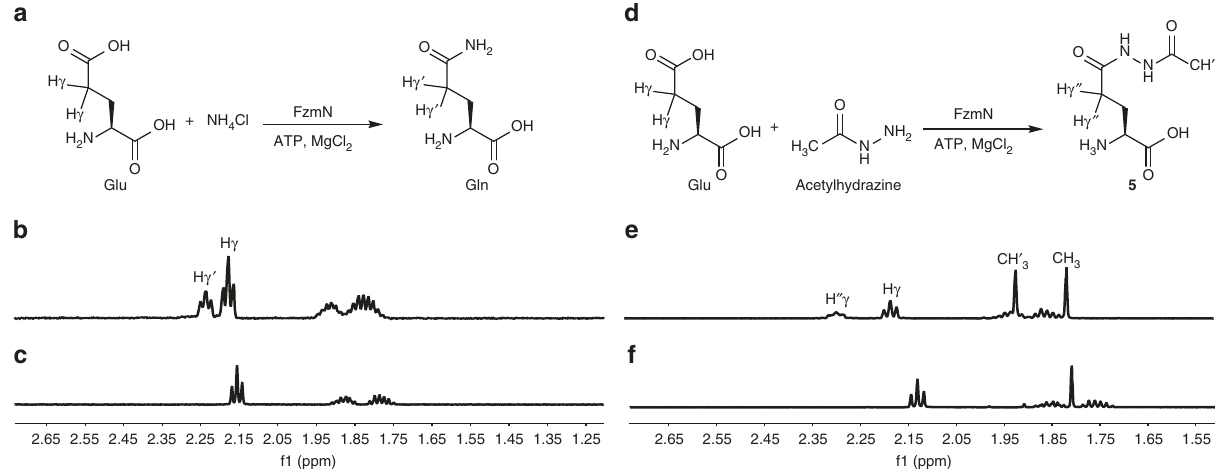
Fig. 4 1 H NMR analysis of FzmN activity. a The canonical glutamine synthetase reaction catalyzed by FzmN. The γ -protons on the Glu substrate (H γ ) and Gln product (H γ ’ ) are highlighted. b 1 H NMR analysis of a reaction mixture containing FzmN, Glu, NH 4 Cl, ATP, and MgCl 2 . Peaks corresponding to the γ -protons on Glu and Gln are indicated. c 1 H NMR analysis of the reaction mixture containing Glu, NH 4 Cl, ATP, and MgCl 2 without FzmN. d The putative reaction catalyzed by FzmN during the biosynthesis of fosfazinomycin. The γ -protons on the Glu substrate ( γ ) and the glutamylacetylhydrazine ( 5 ) product ( γ ” ) and the methyl protons on the acetylhydrazine substrate (CH 3 ) and 5 (CH ’ 3 ) are indicated. e 1 H NMR analysis of the reaction mixture containing FzmN, Glu, acetylhydrazine, ATP, and MgCl 2 . Resonances corresponding to the γ -protons and methyl protons on the substrates and the product are indicated. f 1 H NMR analysis of the reaction mixture containing Glu, acetylhydrazine, ATP, and MgCl 2 without FzmN. The chemical shifts of several of the protons are sensitive to conditions (pH, salt), and hence spiking with authentic materials was used for assignments